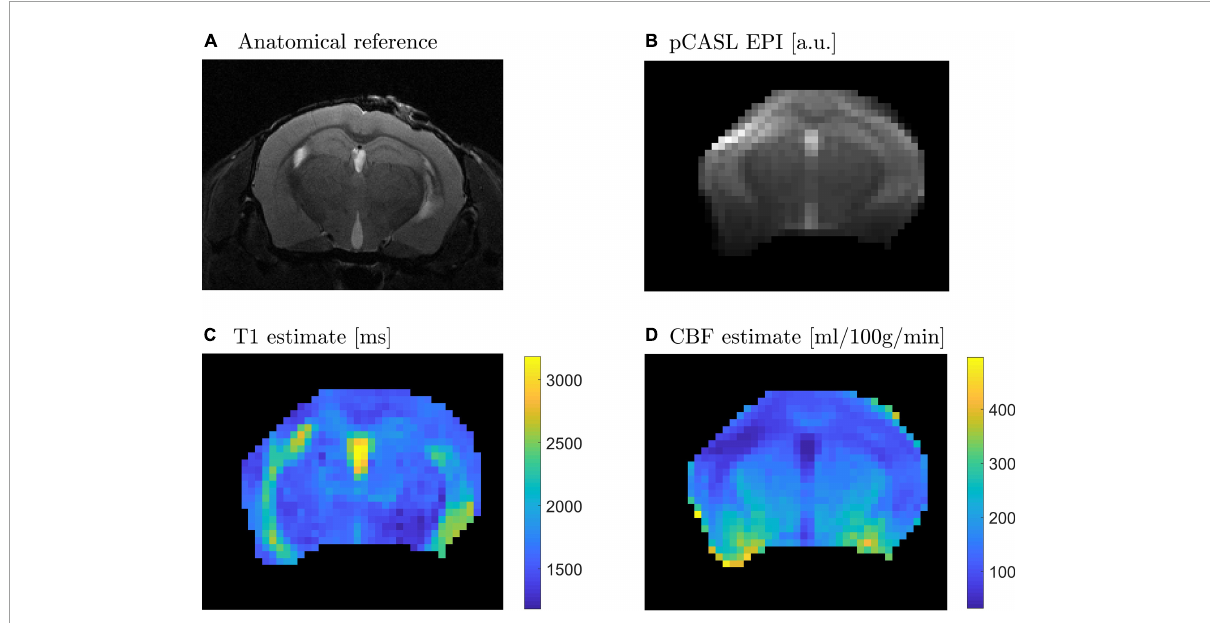
FIGURE6 CBF parameter calculations. (A) Coronal slice as an anatomical reference; (B) EPI image acquired through a pCASL sequence shows only slight blurring along the surface of the brain; (C) Average inversion times in ms; (D) CBF map in ml/100 g